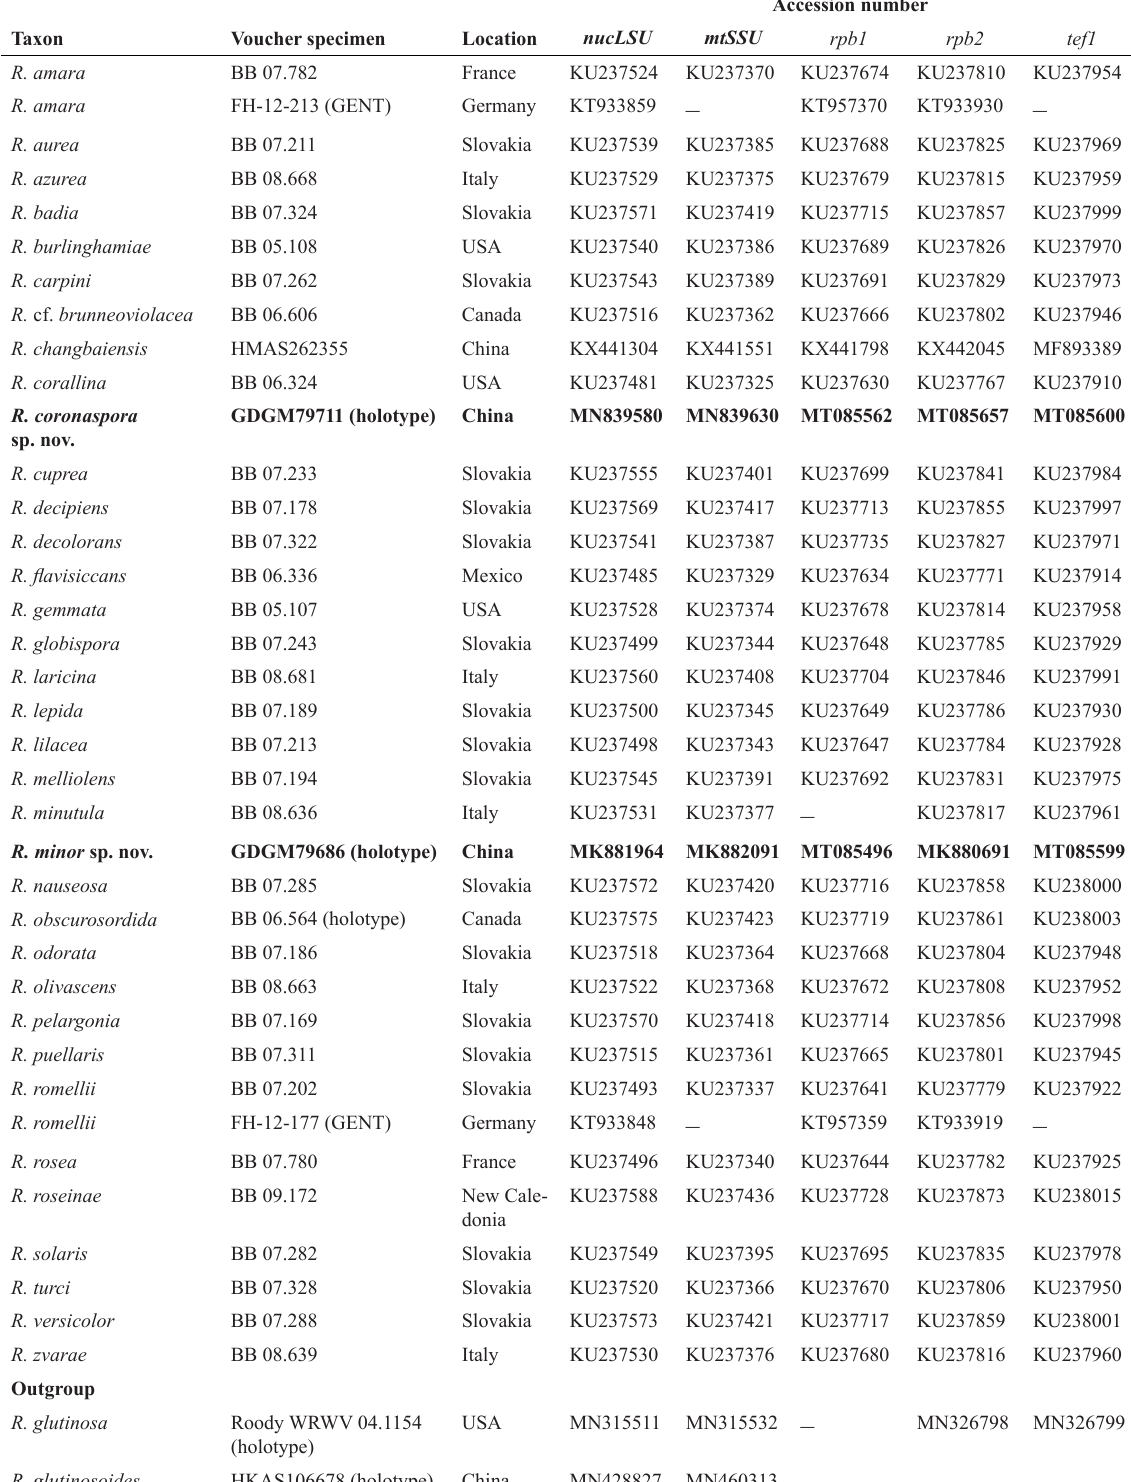
Table 2. Sequences used in phylogenetic analysis based on 5-locus data. Newly generated sequences are shown in